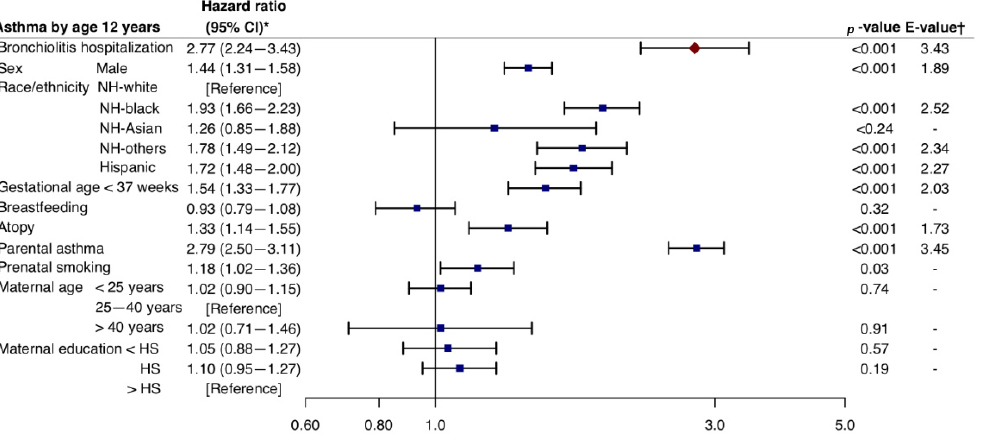
Figure 2. Associations of bronchiolitis hospitalization in infancy with the subsequent development of asthma. * The Cox proportional hazard model was adjusted for 10 potential confounders (sex, race and ethnicity, calendar year of childbirth, gestational age, breastfeeding, child’s atopy, parental asthma, prenatal smoking, maternal age at delivery, and maternal education), accounting for patient clustering by cohort. † The E-value (with its lower 95% CI bound) represents how strongly unmeas- ured confounder(s) would have to be associated with the exposure and outcome in order for the observed association to be independent. Abbreviations: CI, confidence interval; HS, high school; NH, Non-Hispanic.